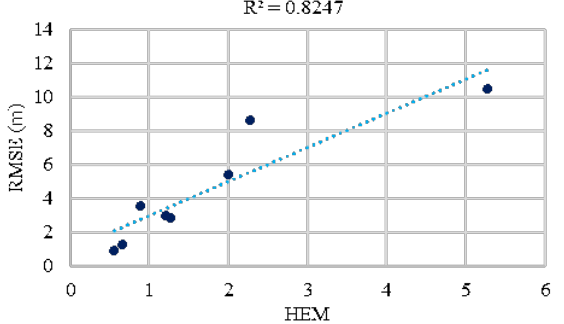
Figure 8. Height residual maps for agricultural and forested area: TanDEM-X DEM (Top) and Cartosat-1 DEM (Bottom)